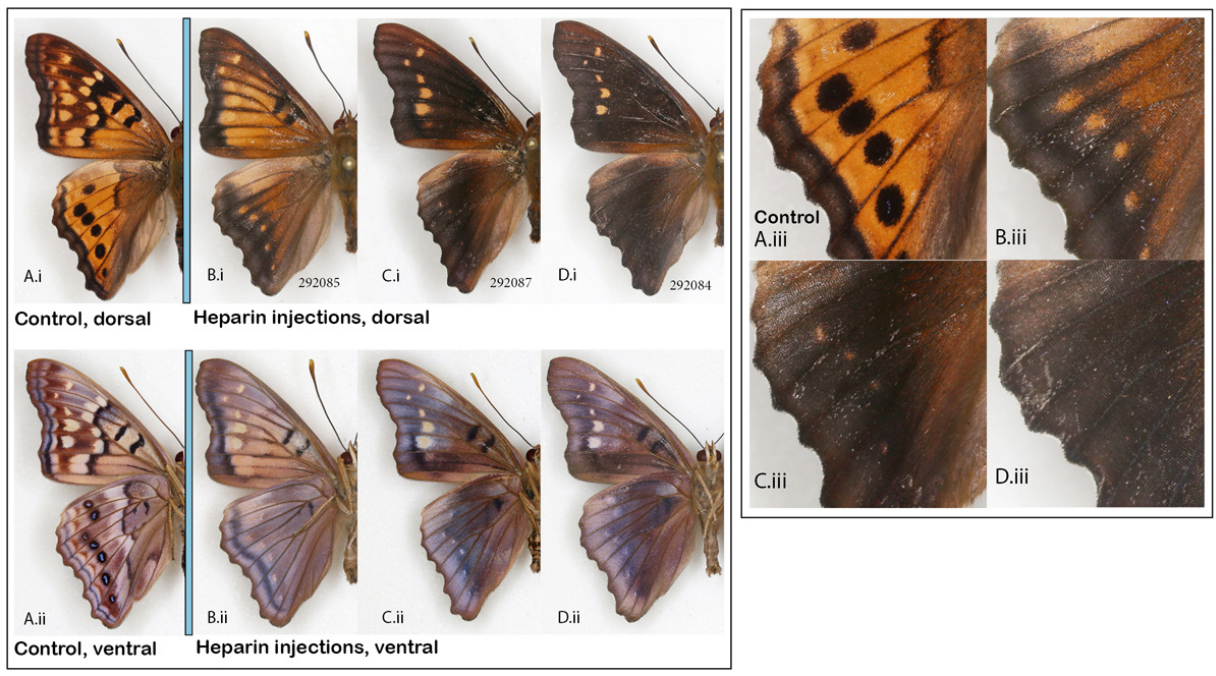
Figure 8. Normal wing pattern ( A ) vs. heparin-induced wing patterns ( B – D ) in the males of the tawny emperor, Asterocampa clyton ; ( i ) dorsal, ( ii ) ventral surfaces, ( iii ) close-up of HWd. See Extended Data (Sourakov, 2020) for